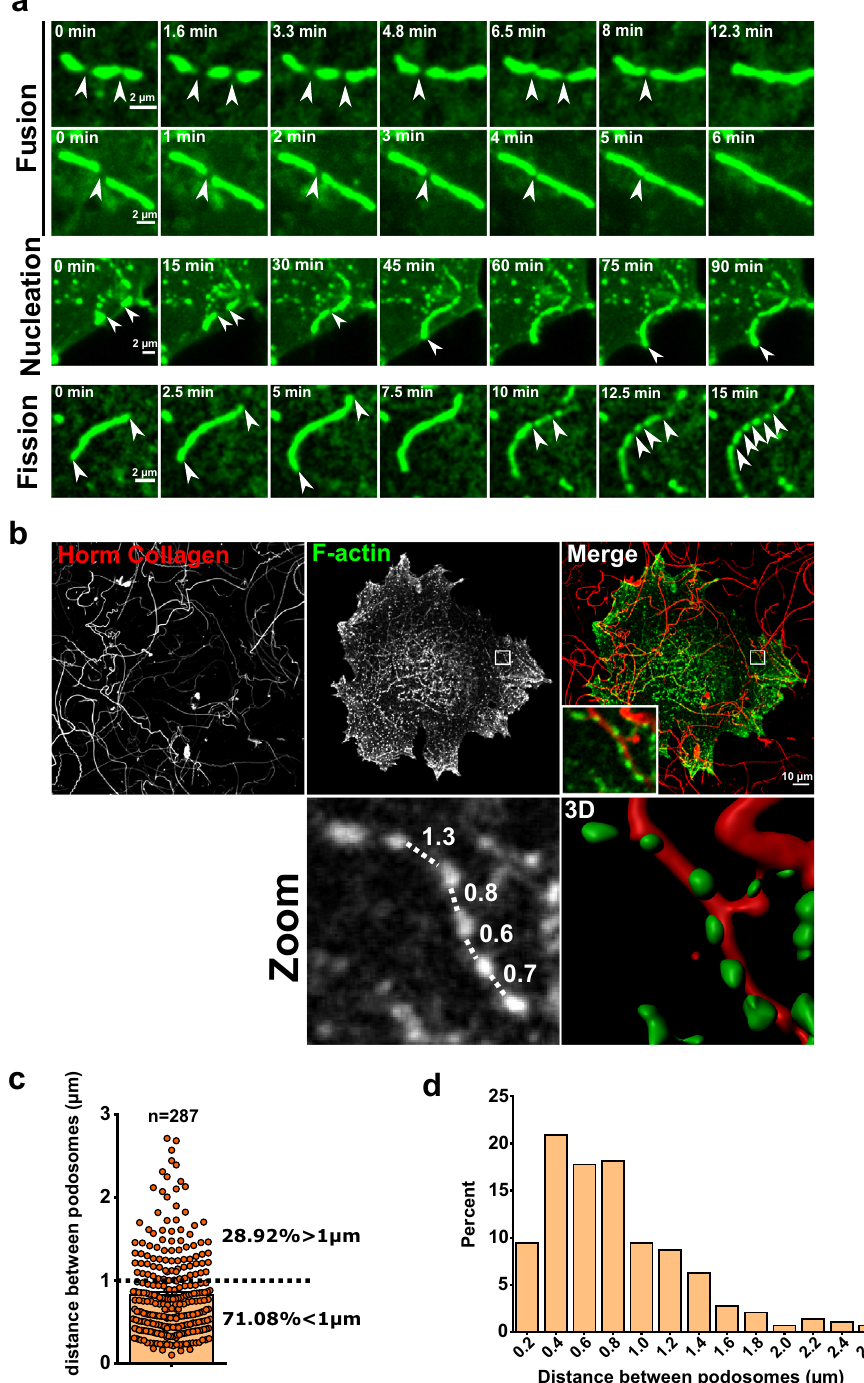
Figure 3. Linear podosomes derive from dynamic fusion of classical dot podosomes. ( a ) Transduced Lifeact-GFP D3MKs were cultured on 100 µg/ml Horm Collagen for 5 h. Movies obtained from confocal videomicroscopy showed podosomes dynamics (fusion, nucleation, fission) at the indicated times. Scale bars = 2 µm. ( b ) Representative images of D3MK cultured on labeled 100 µg/ml Horm Collagen for 5 h. Zooms show respectively the distances (µm) between each dot podosomes along a collagen fiber and the 3D surface rendering of the structure realized with IMARIS. Scale bar = 10 µm. ( c ) Graphical representation of the quantification of distances between dot-like podosomes. Percentages of podosomes separated by more or less of 1 µm are indicated. ( d ) Percentage of the distribution of dot-like podosomes interval along collagen fibers. Data represent analysis of 287 podosomes from